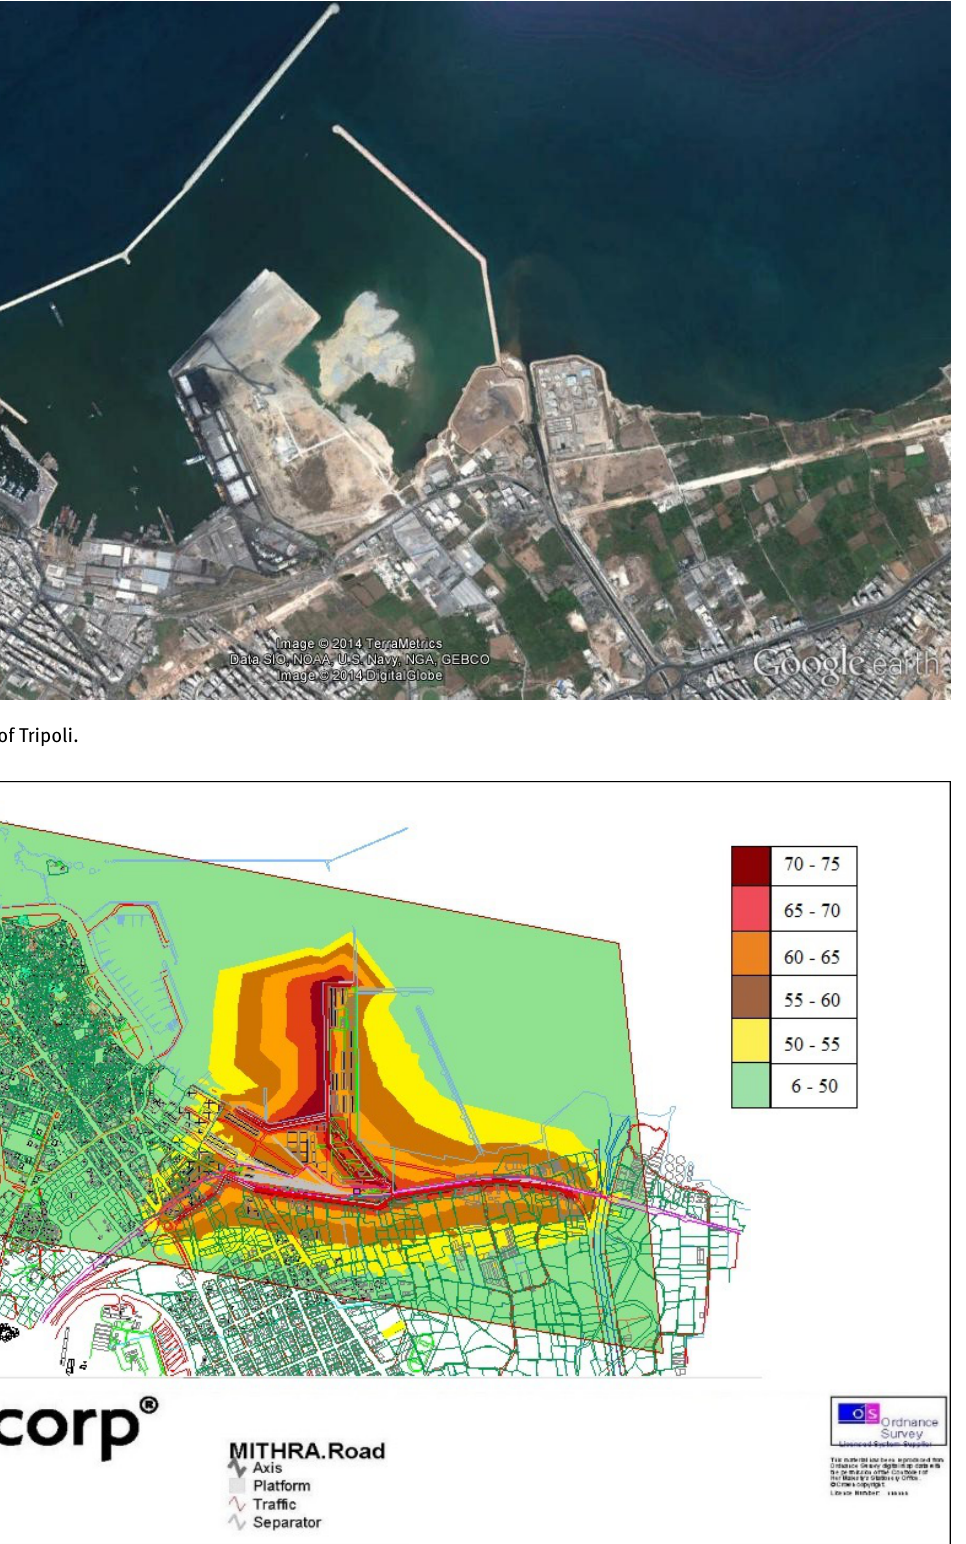
Figure 8: Noise mapping of the Port of Tripoli and the surrounding